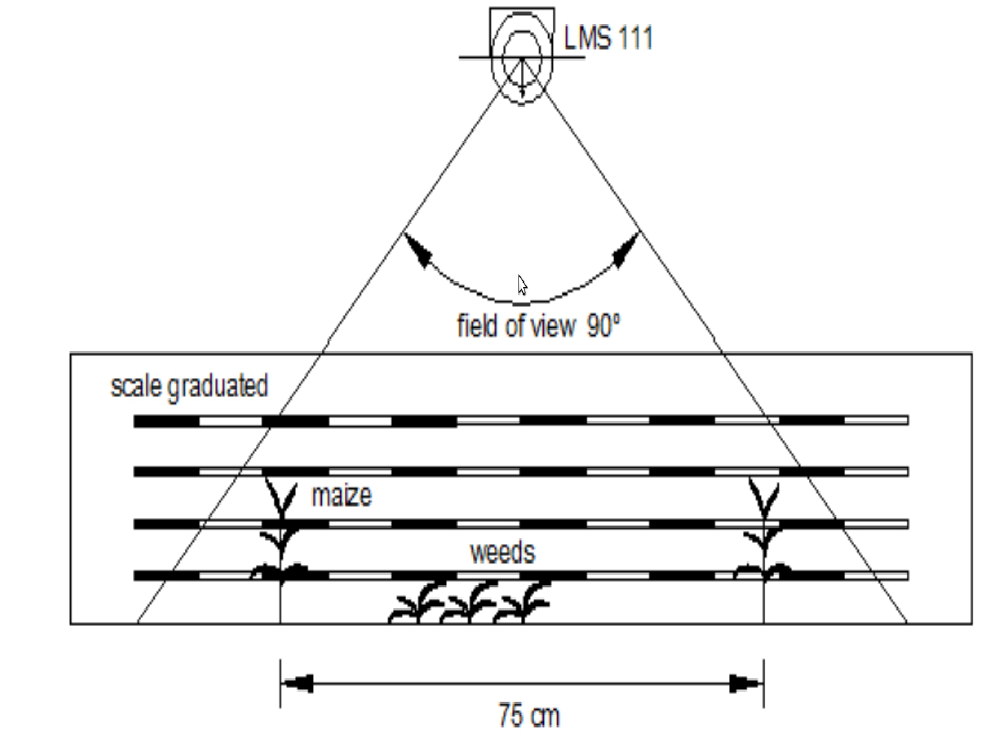
Figure 1. Schematic design of the sampling methodology at scanning